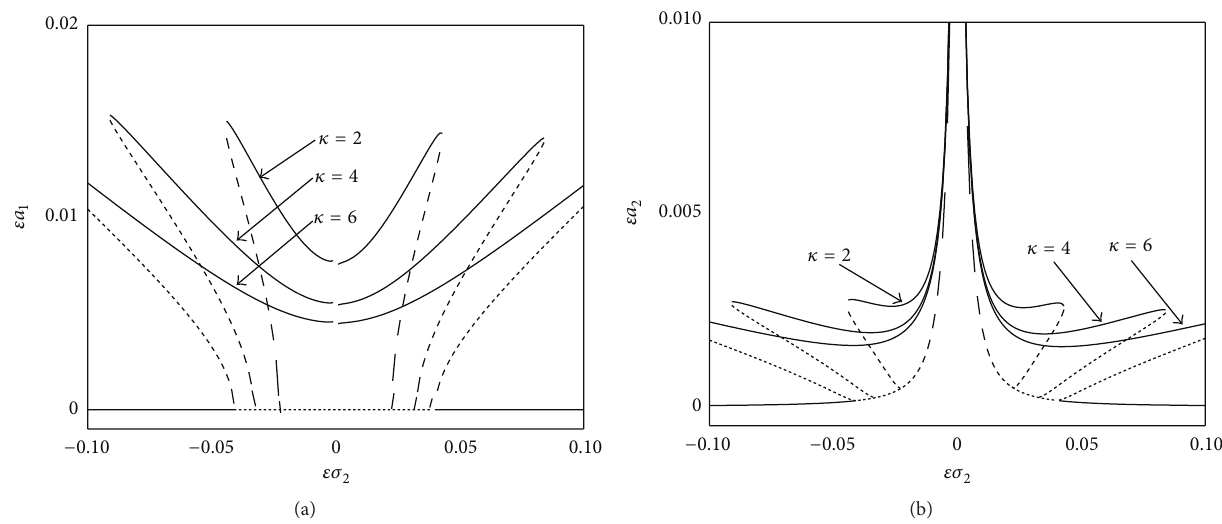
Figure 4: Amplitude-frequency curves of first subharmonic resonance for different nonlinearity coefficients: (a) the first mode and (b) the second mode.